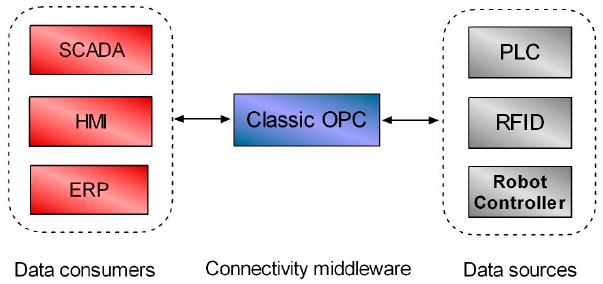
Figure 1. Classic open platform communications (OPC)-based communication scheme in automation system.